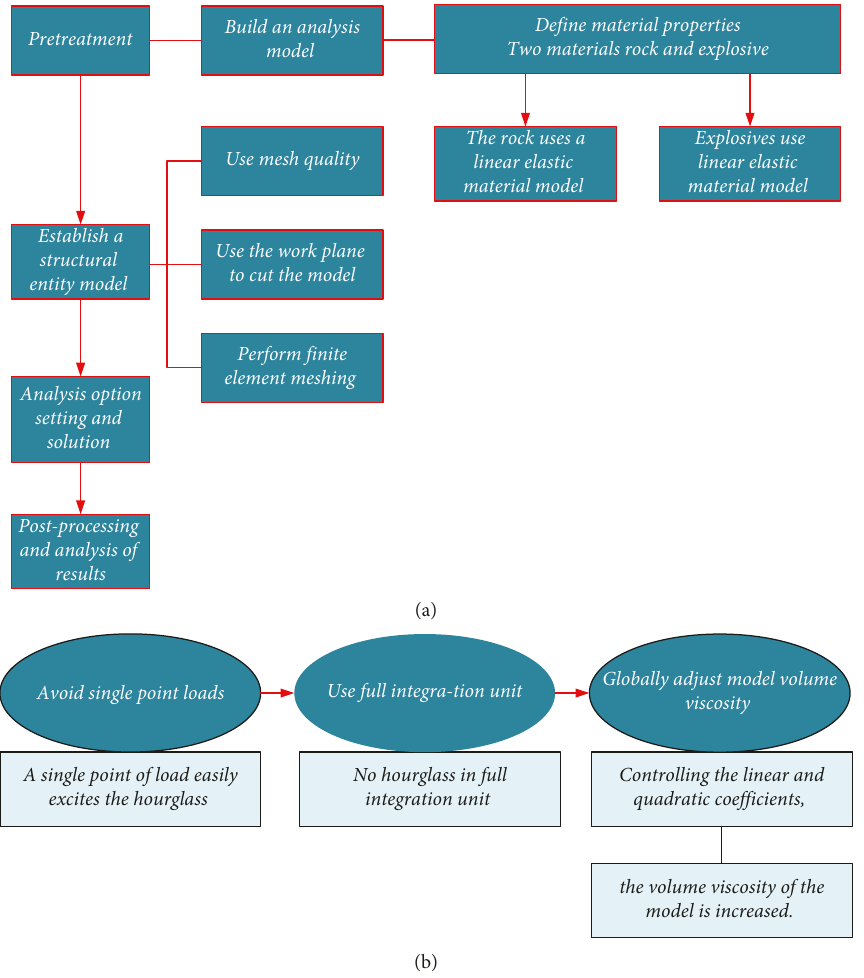
Figure 4: Numerical simulation process. (a) Finite element equation solving process and (b) model hourglass